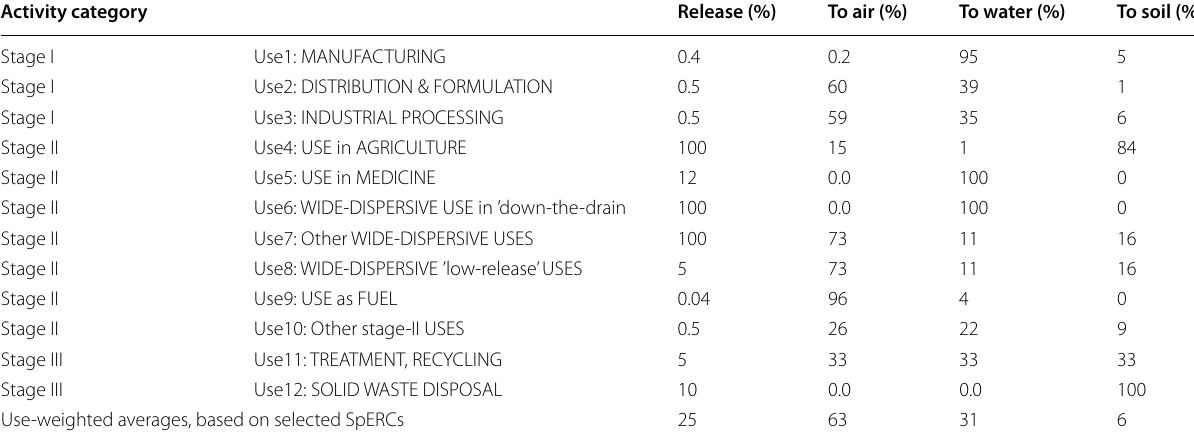
Table 1 Estimated release fractions in the various uses and life cycle stages, based on published and unpublished reports